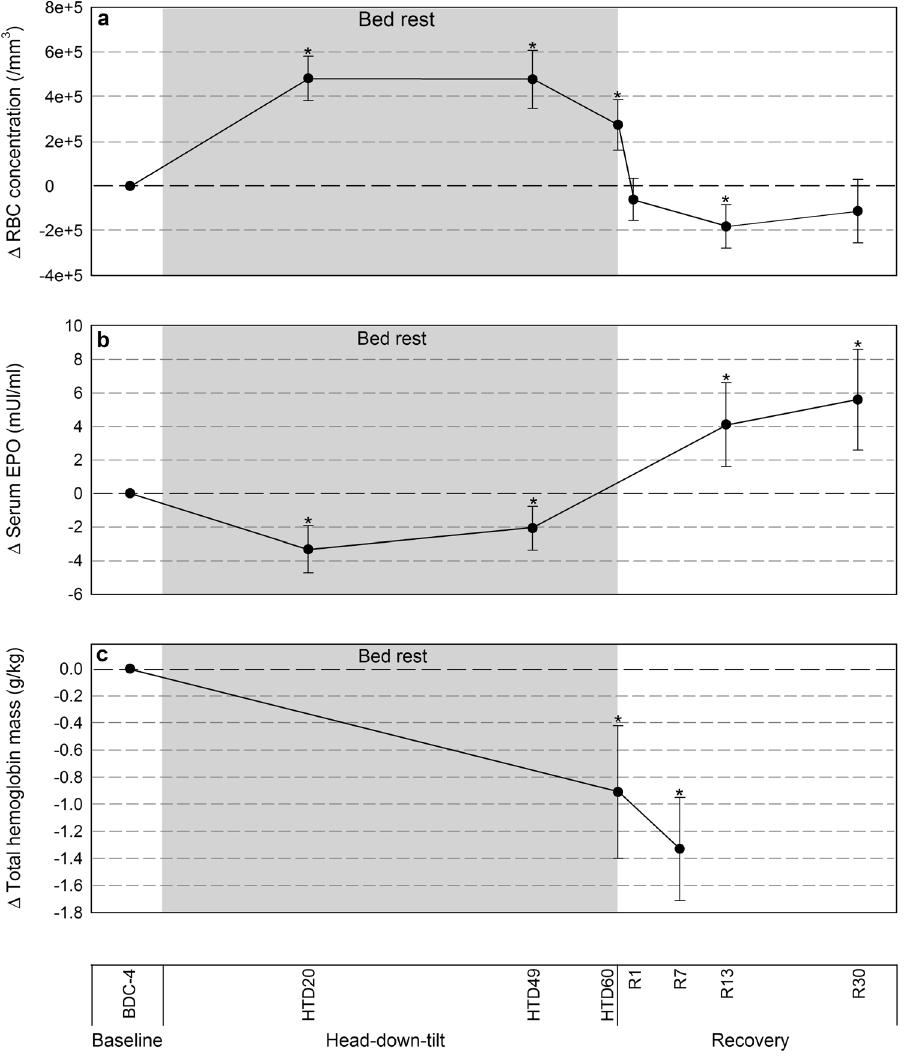
Fig. 3 Erythropoietic changes in 20 male participants before, during and after 60 days of bed rest HDT. a Participants remained hemoconcentrated at all time points during bed rest. Reambulation uncovered lower RBC concentration. b EPO was decreased at all time points during bed rest. EPO increased at reambulation. c Total hemoglobin mass was decreased after 60 days of bed rest and at recovery Day 7. Sixty days of bed rest caused a 77.2 g loss in tHb mass attributed to hemolysis and blood draws. Data expressed as changes from baseline. Shaded area represents the bed rest HDT phase. BDC: Baseline Data Collection; HDT: Head-Down Tilt; R: Recovery or Reambulation. Error bars: 95% Con fi dence Interval. * p < 0.05 compared to